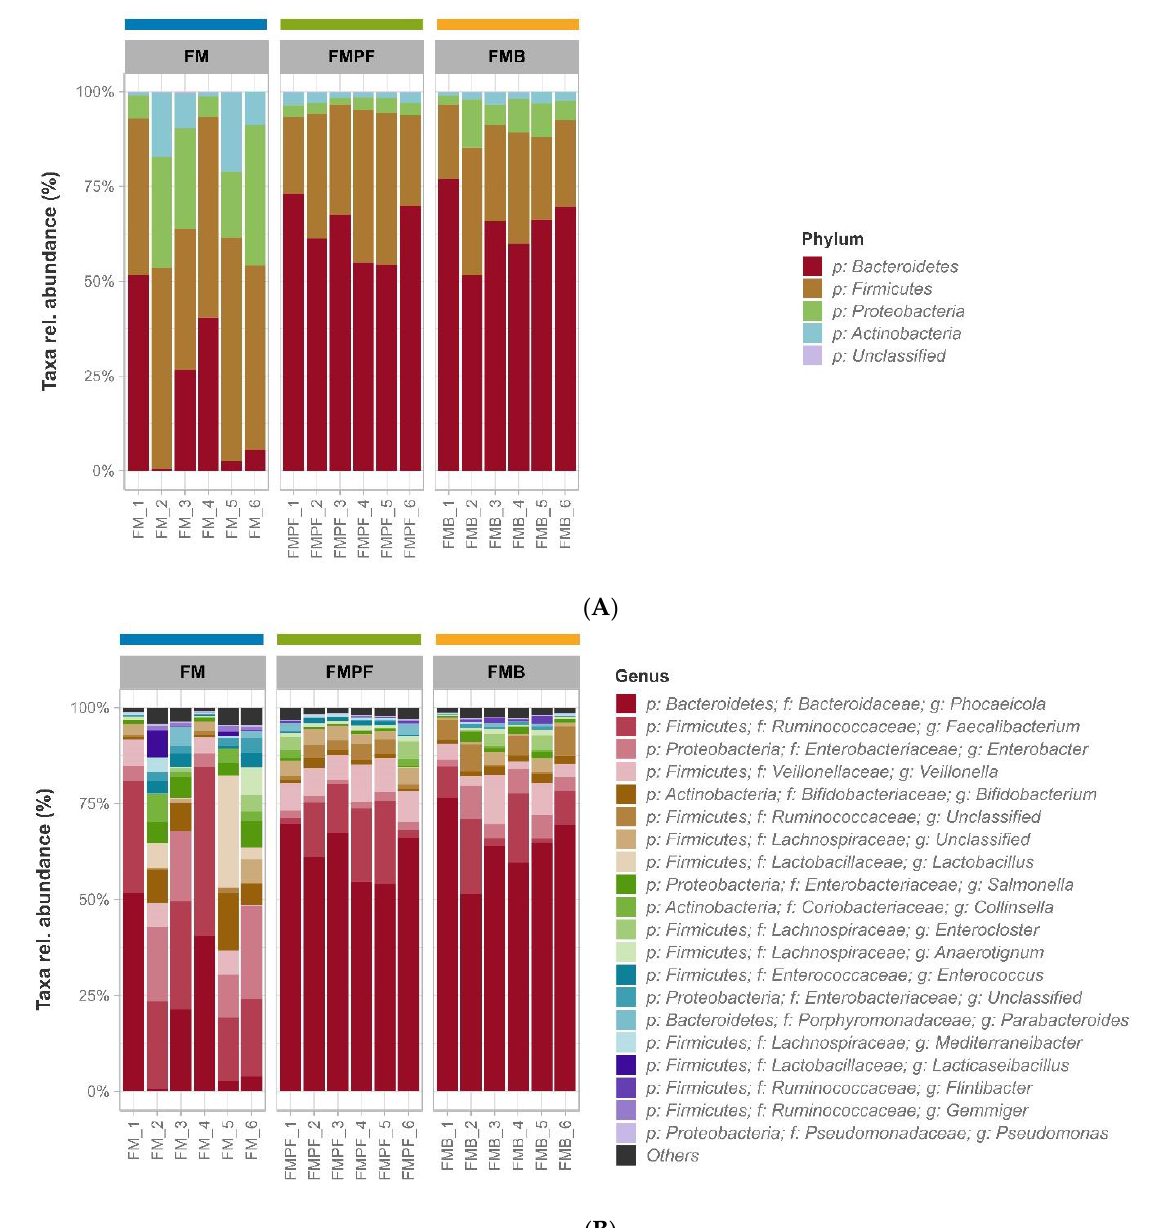
Figure 2. Taxonomic profiles of communities associated with fermented milk without the addition of fruit pulp (FM_1 to FM_6) and with the addition of passion fruit pulp (FMPF_1 to FMPF_6) or buriti pulp (FMB_1 to FMB_6). Relative abundance of phyla ( A ) and 20 most frequent bacterial genera ( B ). Less abundant genera were grouped under category “Others”.